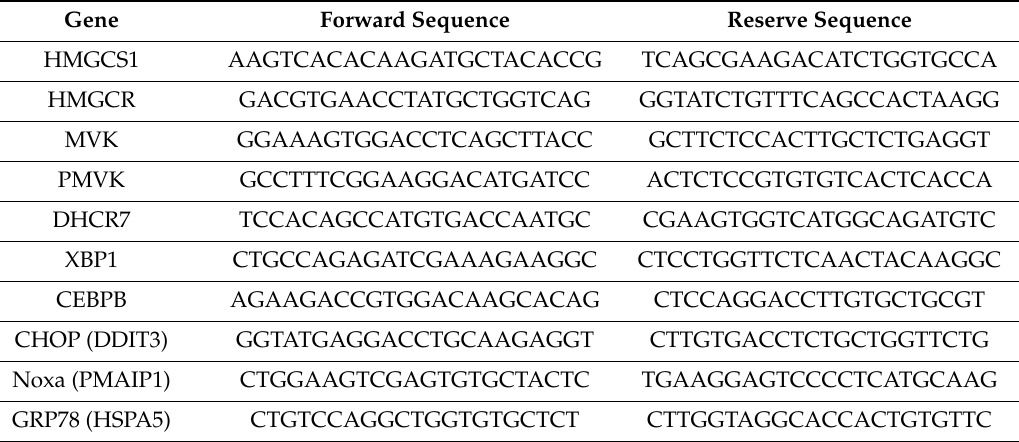
Table 1. Primers for real-time